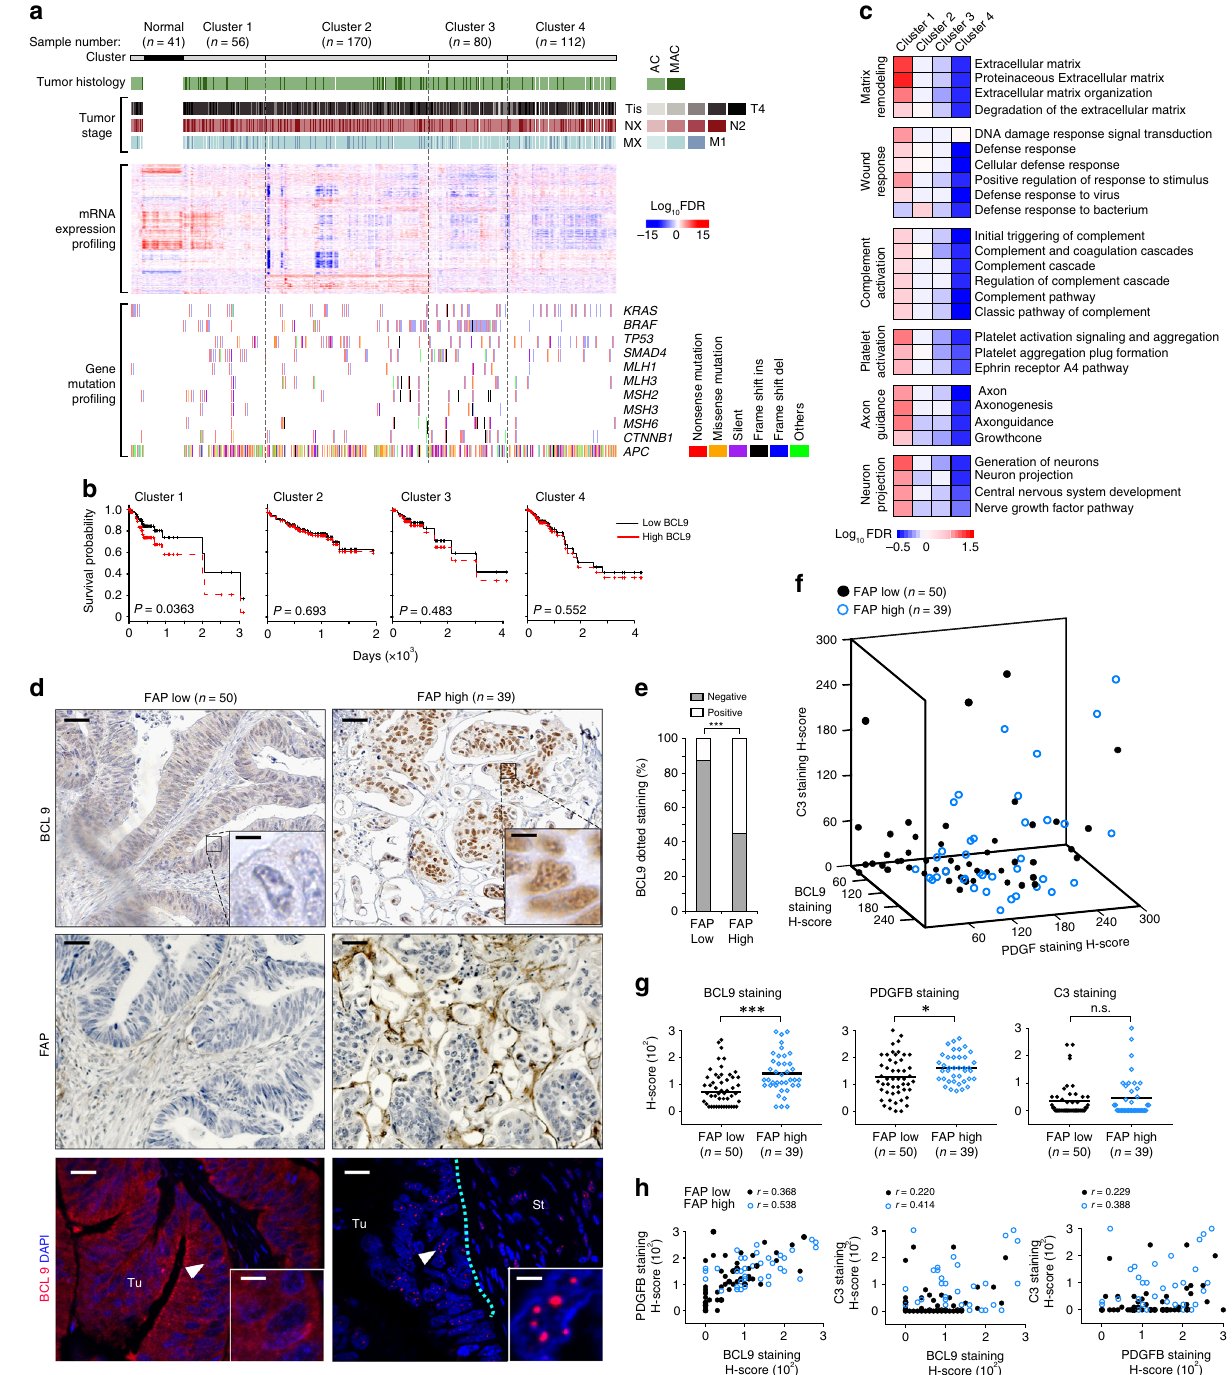
Fig. 1 BCL9 expression within speci fi c molecular subtypes of CRC. a Top: CRC clusters and the corresponding number, histology and stage of samples. Adenocarcinoma (AC); mucinous adenocarcinoma (MAC); tumor, node, metastasis (TNM). Middle: Heat-map of unsupervised clustering of log2 gene expression levels for CRC clusters. Bottom: type of gene mutation. b Cox proportional hazards plot of CRC survival probability according to cluster and BCL9 expression levels (high: top 25%; low: bottom 25%). c GSEA of CRC clusters. Color-code response to log10 FDR level (red and blue: high and low con fi dence, respectively). d Representative immunostains of BCL9 and FAP (top) and immuno fl uorescence (IF) of BCL9 (bottom) according to FAP levels. Note punctate BCL9 nuclear staining in FAP high cases. Tu: tumor; St: stroma. Scale bars: black, 50 µ m (top, left) and 10 µ m (inset); white, 20 µ m (top, left) and 2 µ m (inset). e Distribution of BCL9 punctate staining according to FAP levels. P values were calculated using χ 2 test, *** P < 0.001, f 3D scatter plot of immunostain H-scores for the indicated proteins. g Immunostain H-scores of indicated proteins in FAP low and high groups. P values were calculated using Student ’ s t test, * P < 0.05; *** P < 0.001; ns: not signi fi cant. h Pearson correlation plots of immunostain H-scores of indicated proteins in FAP low and high groups. See also Supplementary Figs. 1, 2, 3 and Supplementary Data